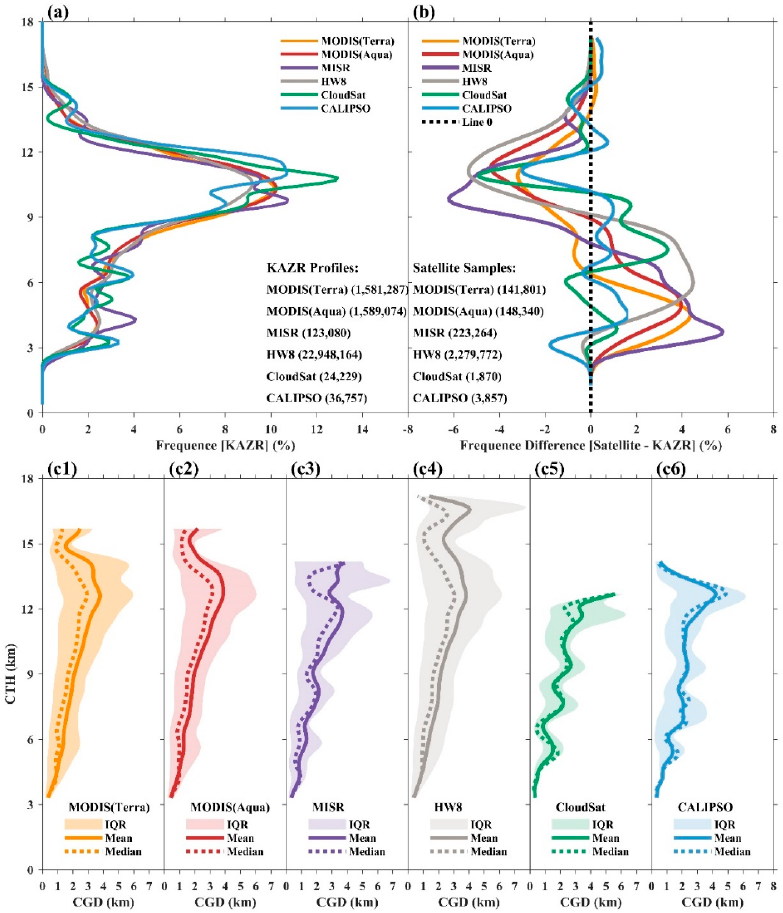
Figure 11. The line graph of ( a ) the difference (satellites minus KAZR) in CTH frequency at each vertical height bin, ( b ) the actual vertical frequency of KAZR CTH corresponding to different spaceborne sensors, and ( c1 – c6 ) the relationship between CTH and CGD corresponding to different satellite-KAZR pair, ( c1 ) MODIS(Terra), ( c2 ) MODIS(Aqua), ( c3 ) MISR, ( c4 ) HW8, ( c5 ) CloudSat, and ( c6 ) CALIPSO. The number of cloudy samples from satellite subpixels and KAZR profiles are also presented. The solid and dotted lines indicate the mean and medium of cloud geometrical depth, respectively. The light shade represents the interquartile range (IQR) of CGD.